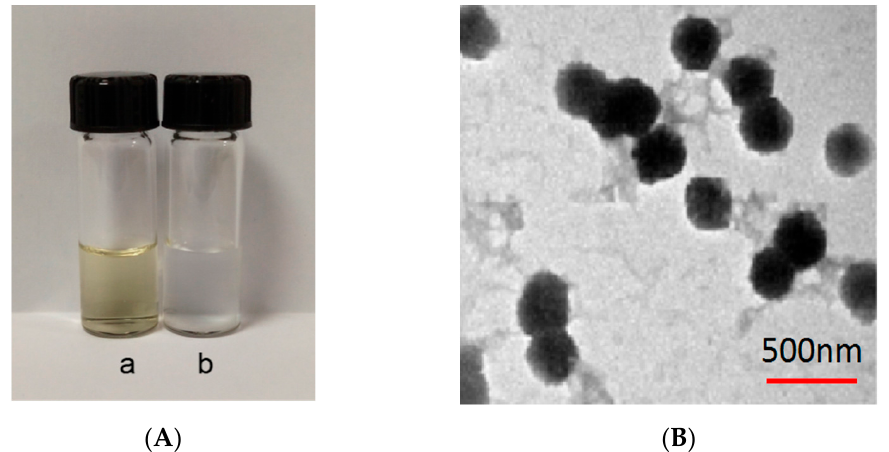
Figure 9. ( A ) a: Gen-NH 2 -MCM-41; b: Gen-NH 2 -MCM-41@SA nanoparticles; ( B ) electron microscopy of Gen-NH 2 -MCM-41@SA nanoparticles.